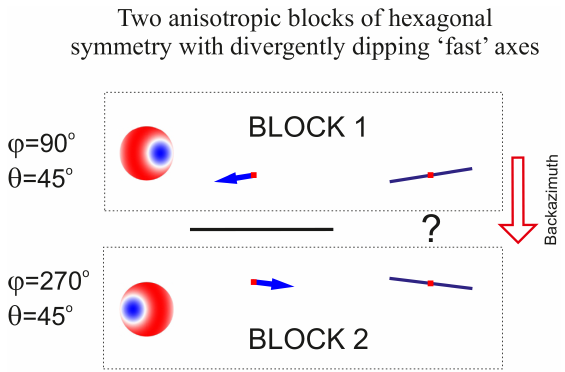
Figure 4. Fast S polarizations evaluated for synthetics propagating through two blocks with divergently inclined fast symmetry axes. The “arrow style” of presentation shows the domain boundary while the standard approach (azimuthal) does not.